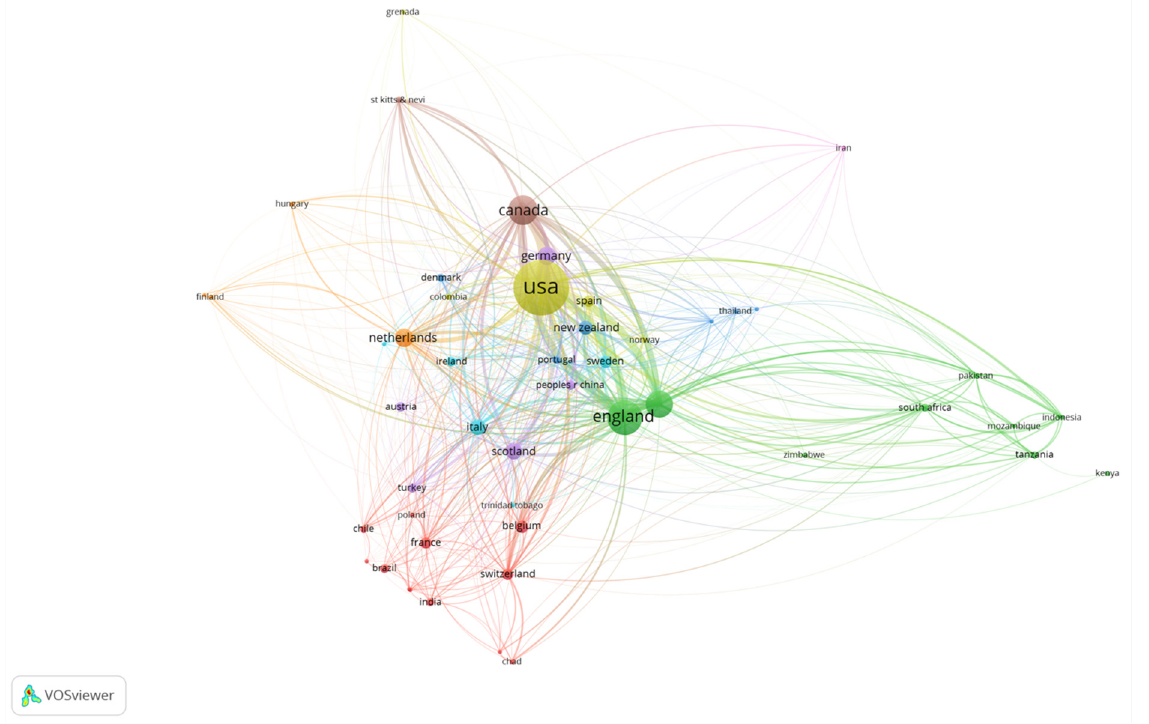
Figure 3. Country collaboration analysis of 677 veterinary communication education publications (VCEPs) from 2000 to 2021.